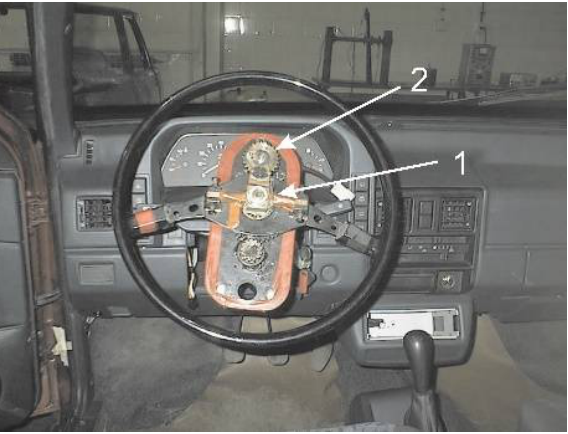
Figure 2. Dynamometric steering wheel for measurement of the steering wheel torque and the steering wheel angle [31].